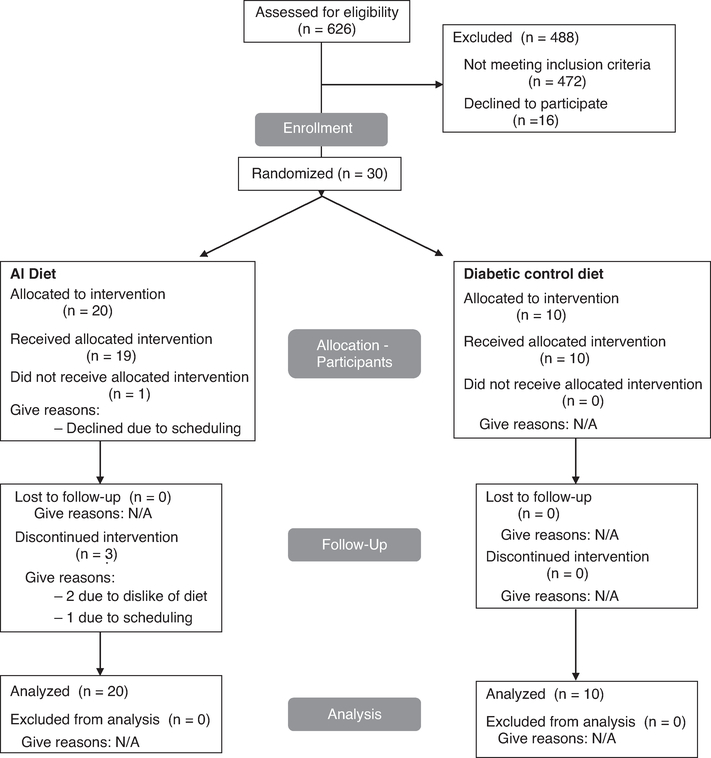
Flow diagram for study recruitment, enrollment, and retention.